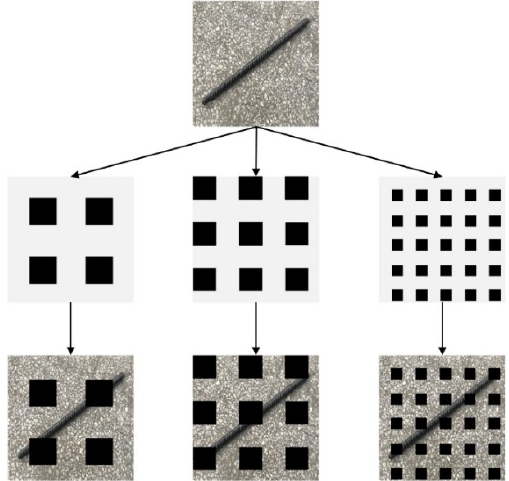
Figure 23. Multiply the image with the